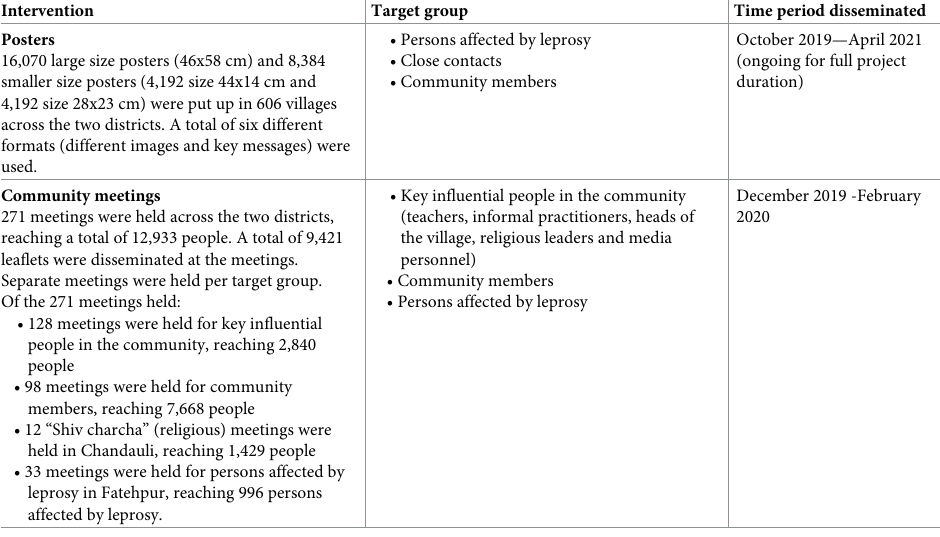
Intervention Target group Time period